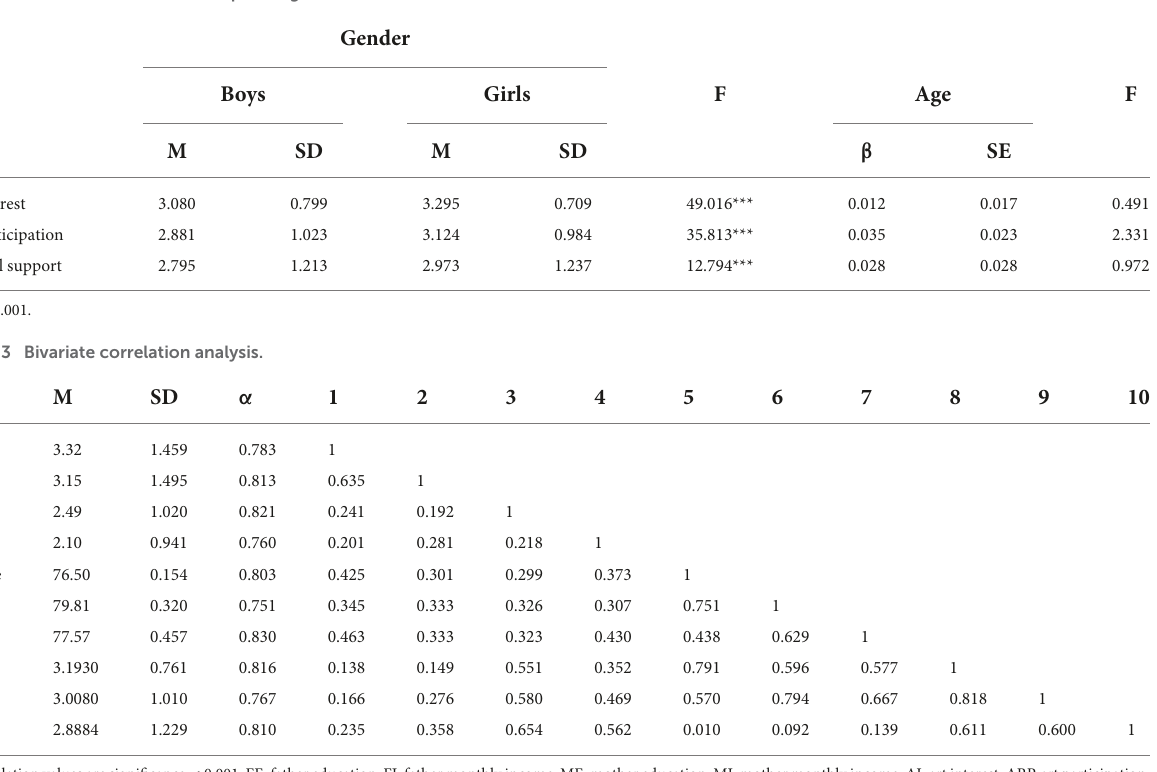
TABLE 2 MANCOVA result of the operating variables.